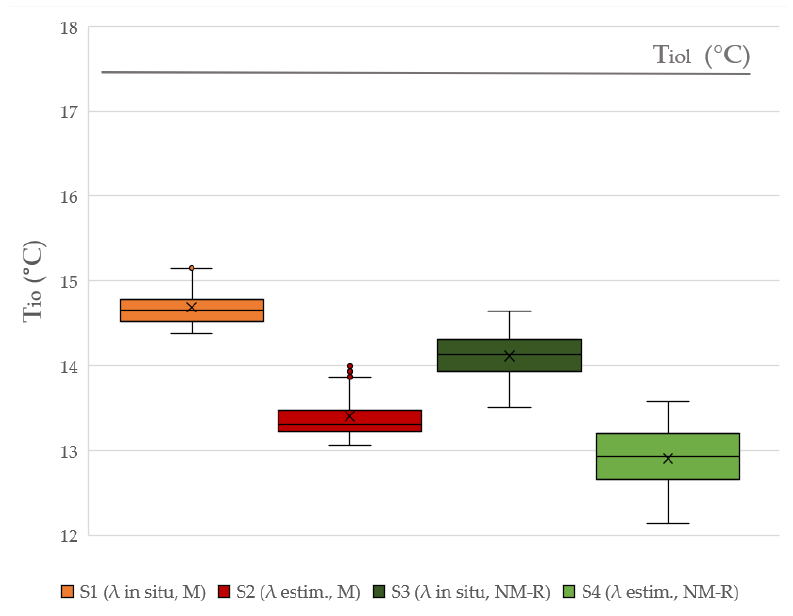
Figure 7. Indoor operative temperature values in simulations (8–14 January 2018). No heating devices.